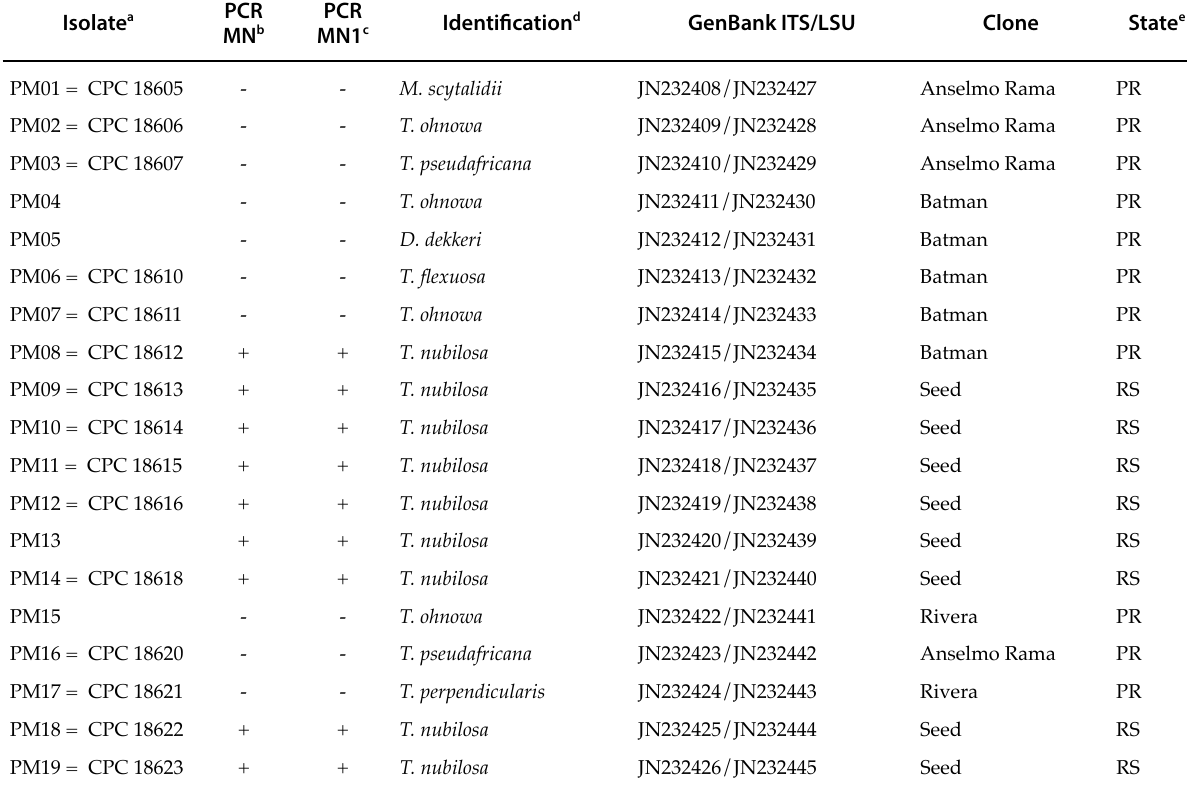
Table 1. Species of Mycosphaerella and Teratosphaeria , associated with Eucalyptus globulus leaf disease in Brazil. Isolate